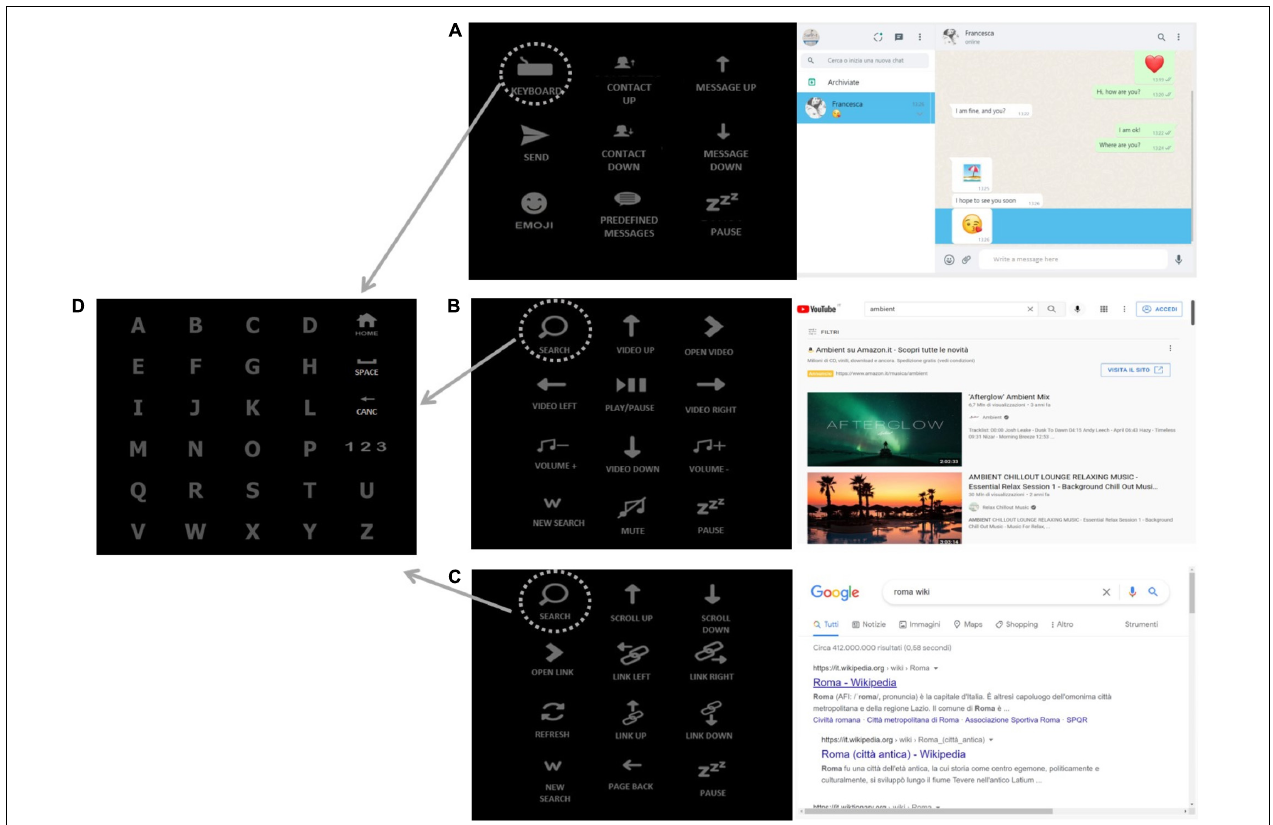
FIGURE 2 | The h-BCI system interfaces. (A) WhatsApp interface: “contact up” and “contact down” icons allow the user to scroll through the contacts, the “keyboard icon” (in the upper-left corner of the matrix) allows to open the keyboard (D) and spell the message, the message is sent by selecting the “send” icon. “Message up” and “message down” icons allow the user to scroll through the messages received within a contact chat. (B) YouTube interface : the “search” icon (in the upper-left corner of the matrix) is selected to search the desired item by opening the keyboard (D) and spelling a keyword, the “arrow” icons (video up, video down, video left, and video right) are selected to scroll through the videos displayed on the screen; “open video” icon allows to choose the desired item and the “play/pause” one to start and stop the video. (C) Google Chrome interface : the “search” icon (in the upper-left corner of the matrix) is selected to search the desired link, the “scroll up” and “scroll down” icons allow to scroll the links displayed on the screen, “open link” icon allows to choose the link to be opened. (D) Keyboard: the keyboard matrix is accessed by selecting the “keyboard” (A) and the “search” (B,C) icons on the main